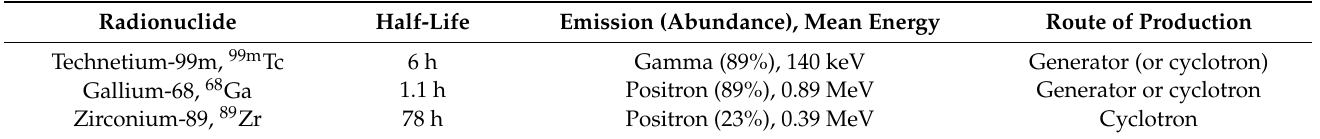
Table 1. Physical properties of radionuclides discussed. Radionuclide Half-Life Emission (Abundance), Mean Energy Route of Production Technetium-99m, 99m Tc 6 h Gamma (89%), 140 keV Generator (or